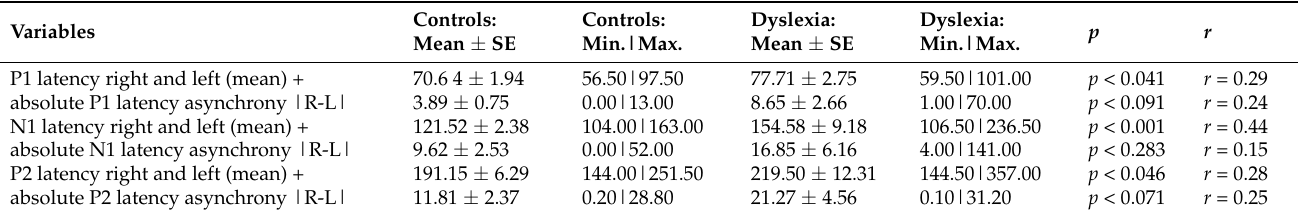
Table 1. The independent t -tests and the descriptives of the MEG variables.